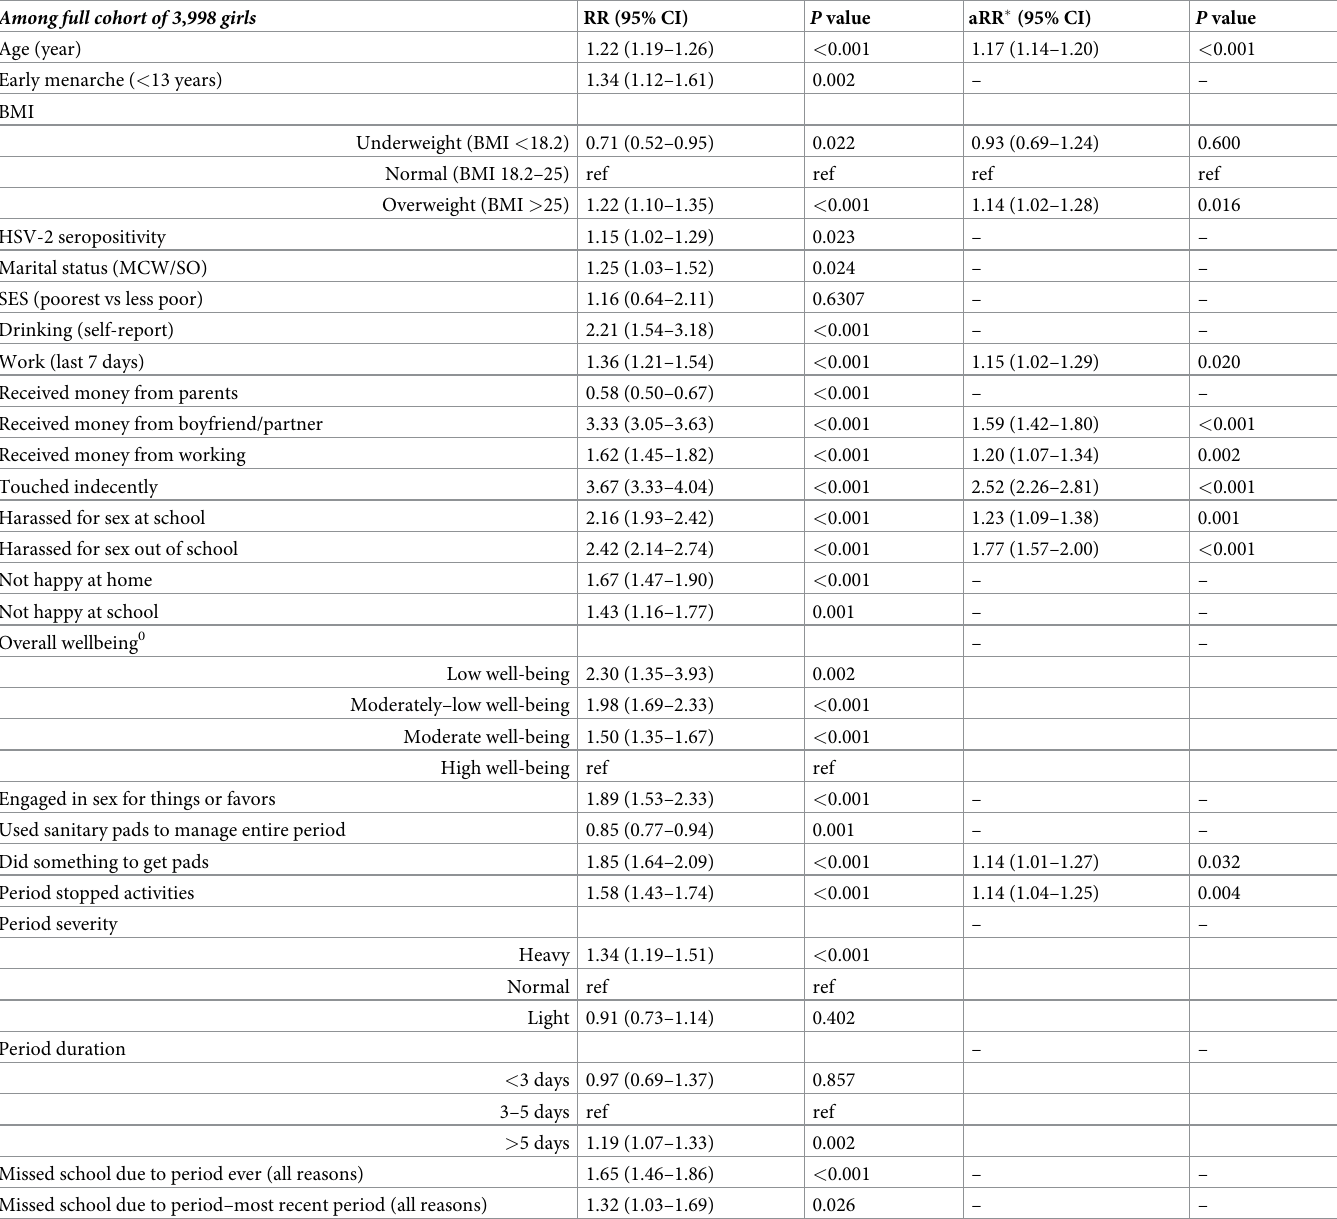
Table 3. Relationship between individual risk factors and sexual activity among girls attending secondary school, Siaya County, western Kenya, 2017–2018. Among full cohort of 3 , 998